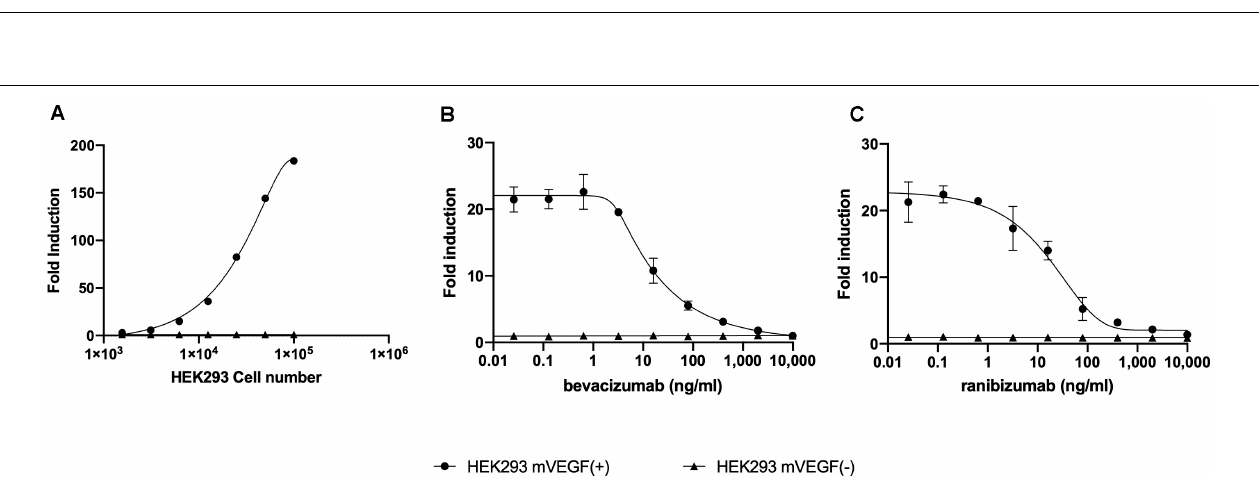
FIGURE 2 | Increasing concentrations of HEK293 mVEGF (+) target cells were incubated with 2.5 × 10 4 of the VEGF responsive reporter-gene cell line for 18 h at 37 ◦ C prior to the quantification of FL activity as described in the section “Materials and Methods” (A) . Increasing concentration bevacizumab (B) or ranibizumab (C) were mixed with 10,000 mVEGF (+) target cells, sufficient to give an approximately 20-fold increase in the FL response of the VEGF responsive reporter-gene cell line, or 10,000 mVEGF ( − ) target cells for 30 min at room temperature prior to incubation for 18 h at 37 ◦ C with the VEGF responsive reporter-gene cell line and quantification of FL activity as described in the section “Materials and